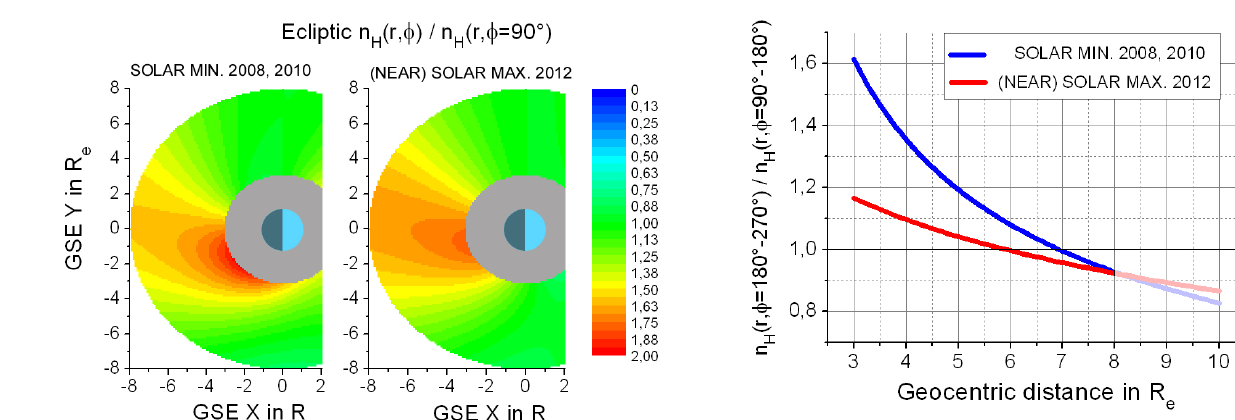
Figure 13. Regions of enhanced H densities at the Earth’s night- side within the ecliptic plane. The images show the ratio of the lo- cal ecliptic densities N(r,φ) and the ecliptic dusk density N(r,φ = 90 ◦ ) for solar minimum (left) and solar maximum (right).